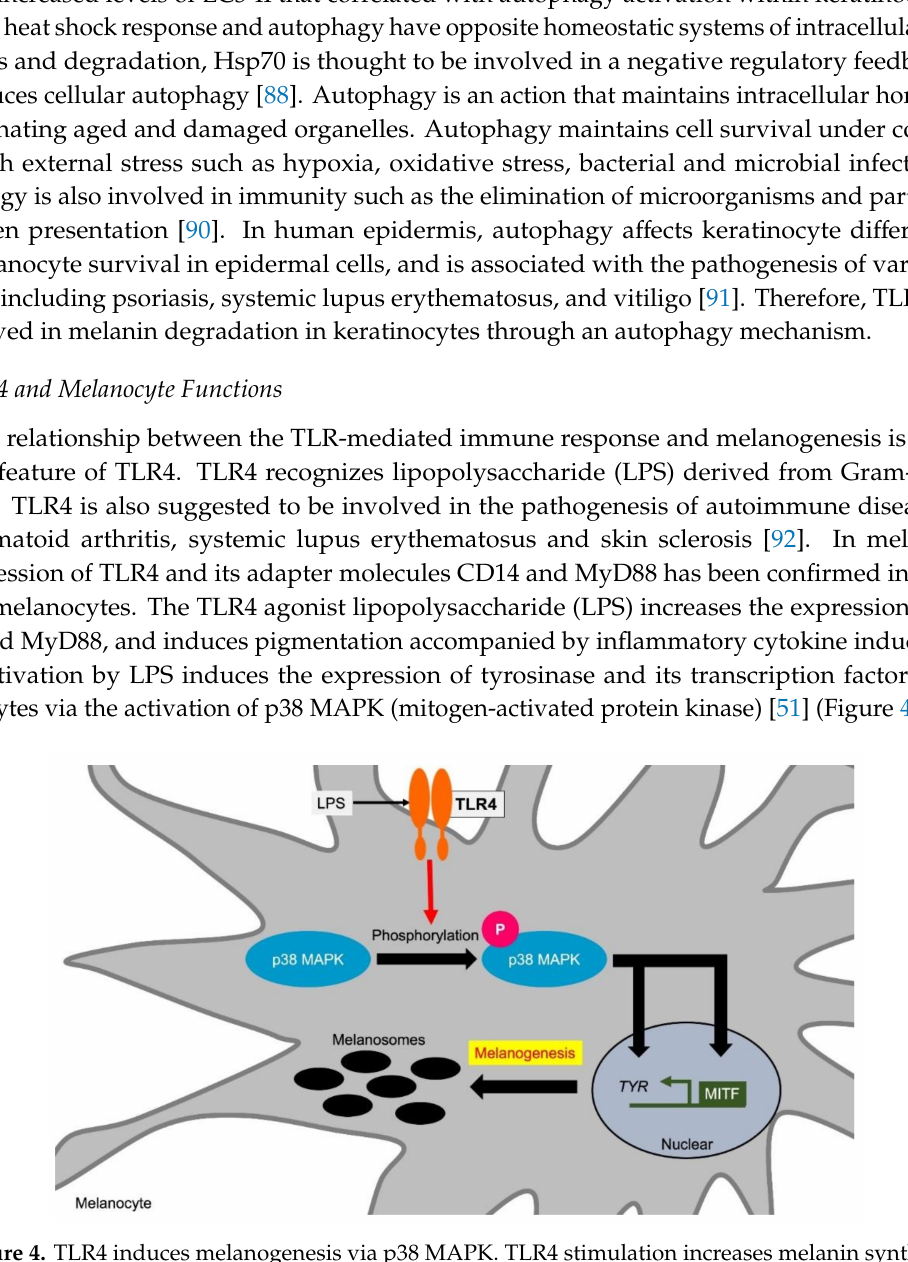
Figure 4. TLR4 induces melanogenesis via p38 MAPK. TLR4 stimulation increases melanin synthesis by inducing the expression of TYR and its transcription factor MITF. TYR and MITF induction are mediated via p38 MAPK phosphorylation by TLR4 stimuli. Abbreviations: TLR: toll-like receptor; MITF: microphthalmia-associated transcription factor; TYR: tyrosinase; MAPK: mitogen-activated protein kinase; LPS: